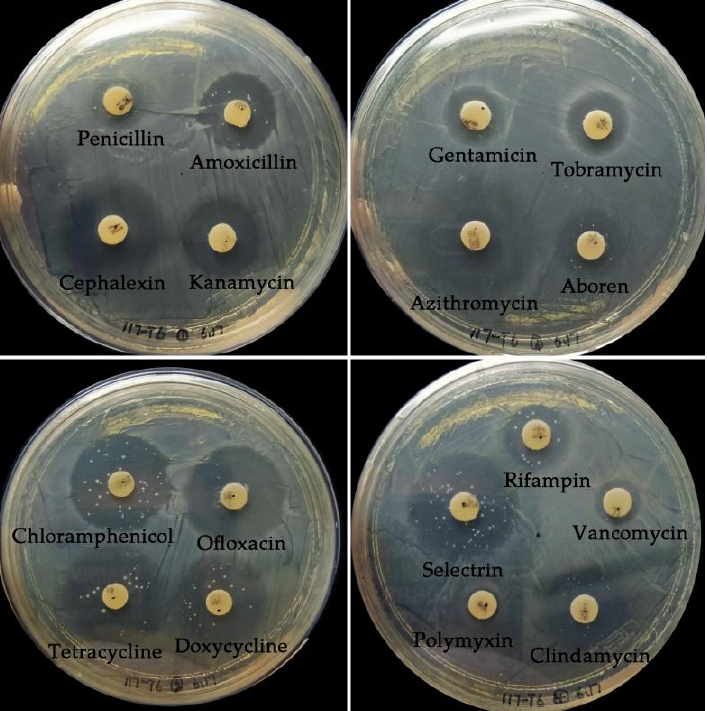
Figure 1. Results of antibiotic susceptibility test. The size of the inhibition zone indicates the susceptibility of bacteria to antibiotics following the standard of the Clinical & Laboratory Standards Institute (CLSI).